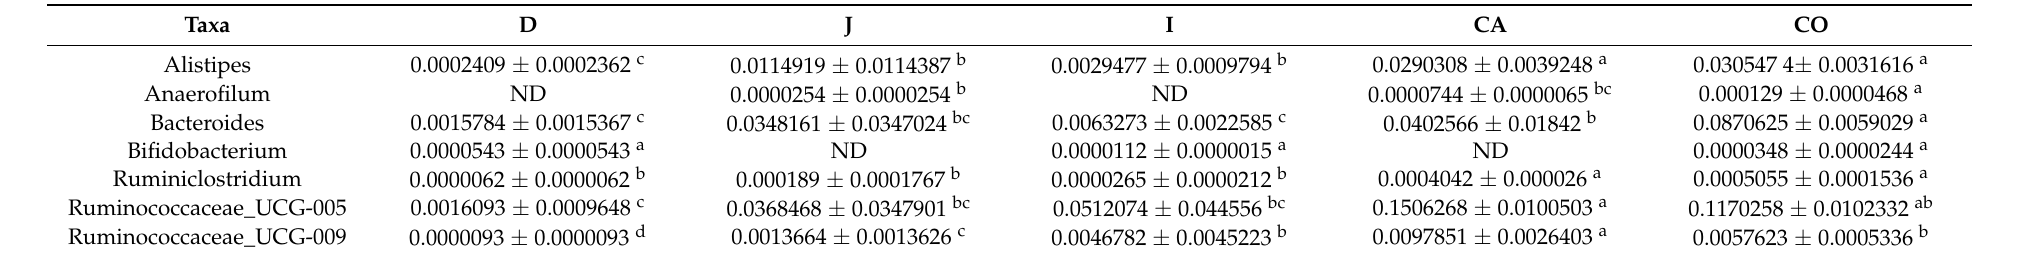
Table 1. Comparison of microbial abundance among different intestinal segments. Different letters represent significant differences. “ND” means not